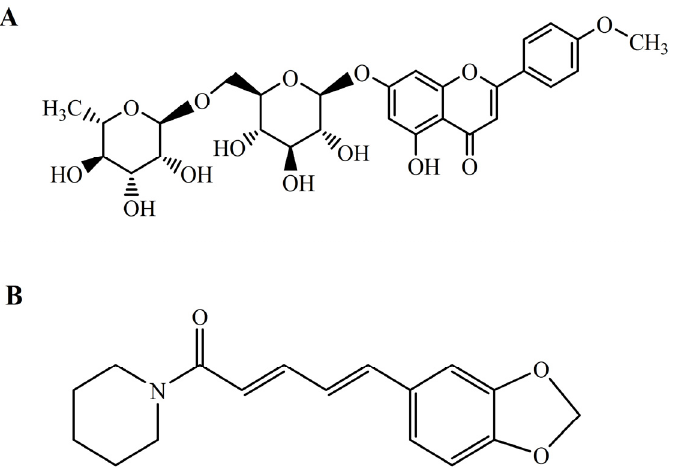
Figure 1. Chemical structures of linarin ( A ) and piperine ( B